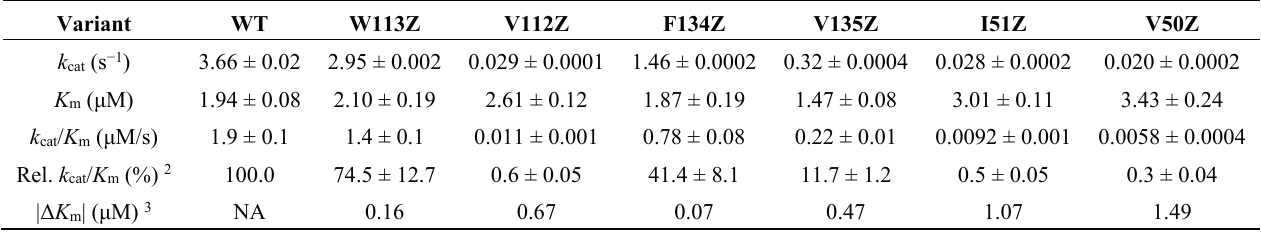
Table 2. Michaelis-Menten kinetic parameters for DHF reduction by mDHFR 1